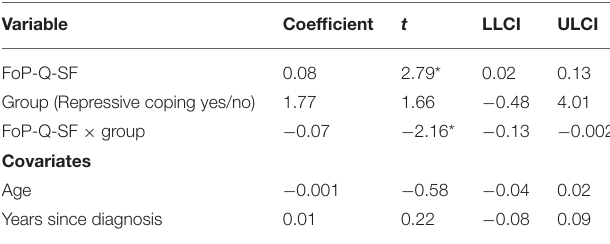
TABLE 4 | Association between fear of progression and defensive functioning (DMRS) in male breast cancer patients with vs. without repressive coping.